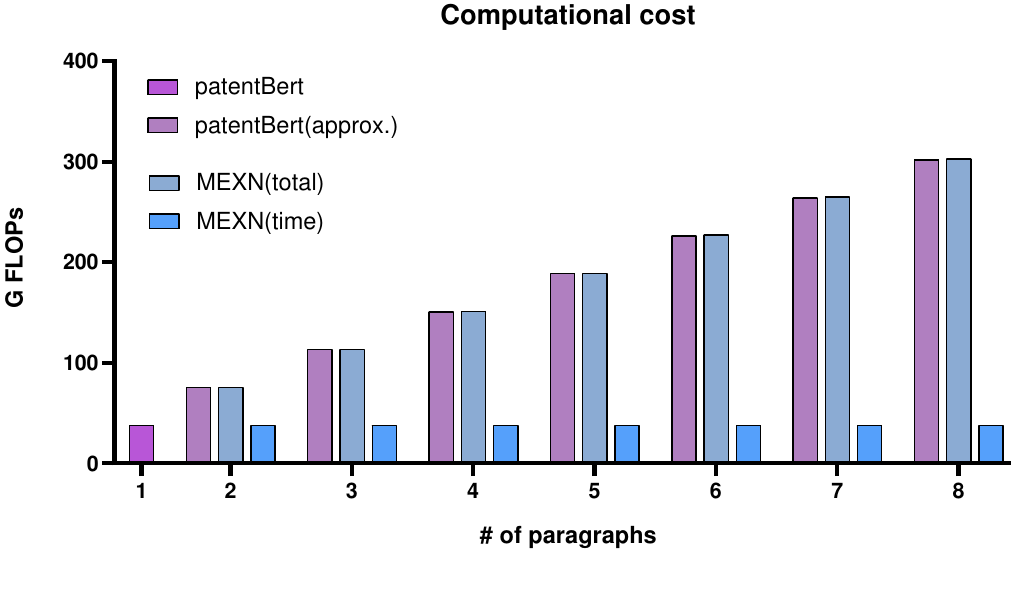
Figure 4. Computational cost